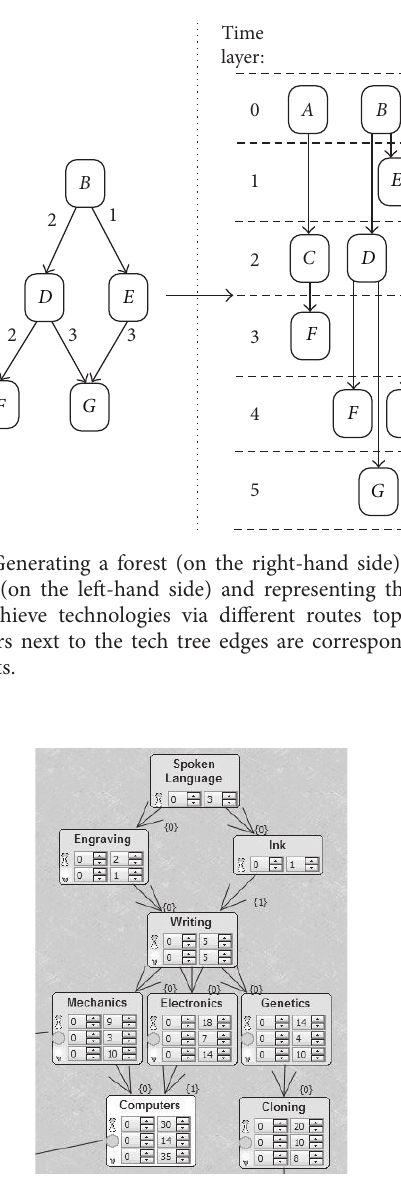
Figure 4: A part of a simple example tech tree. A partial screen capture from TTT.